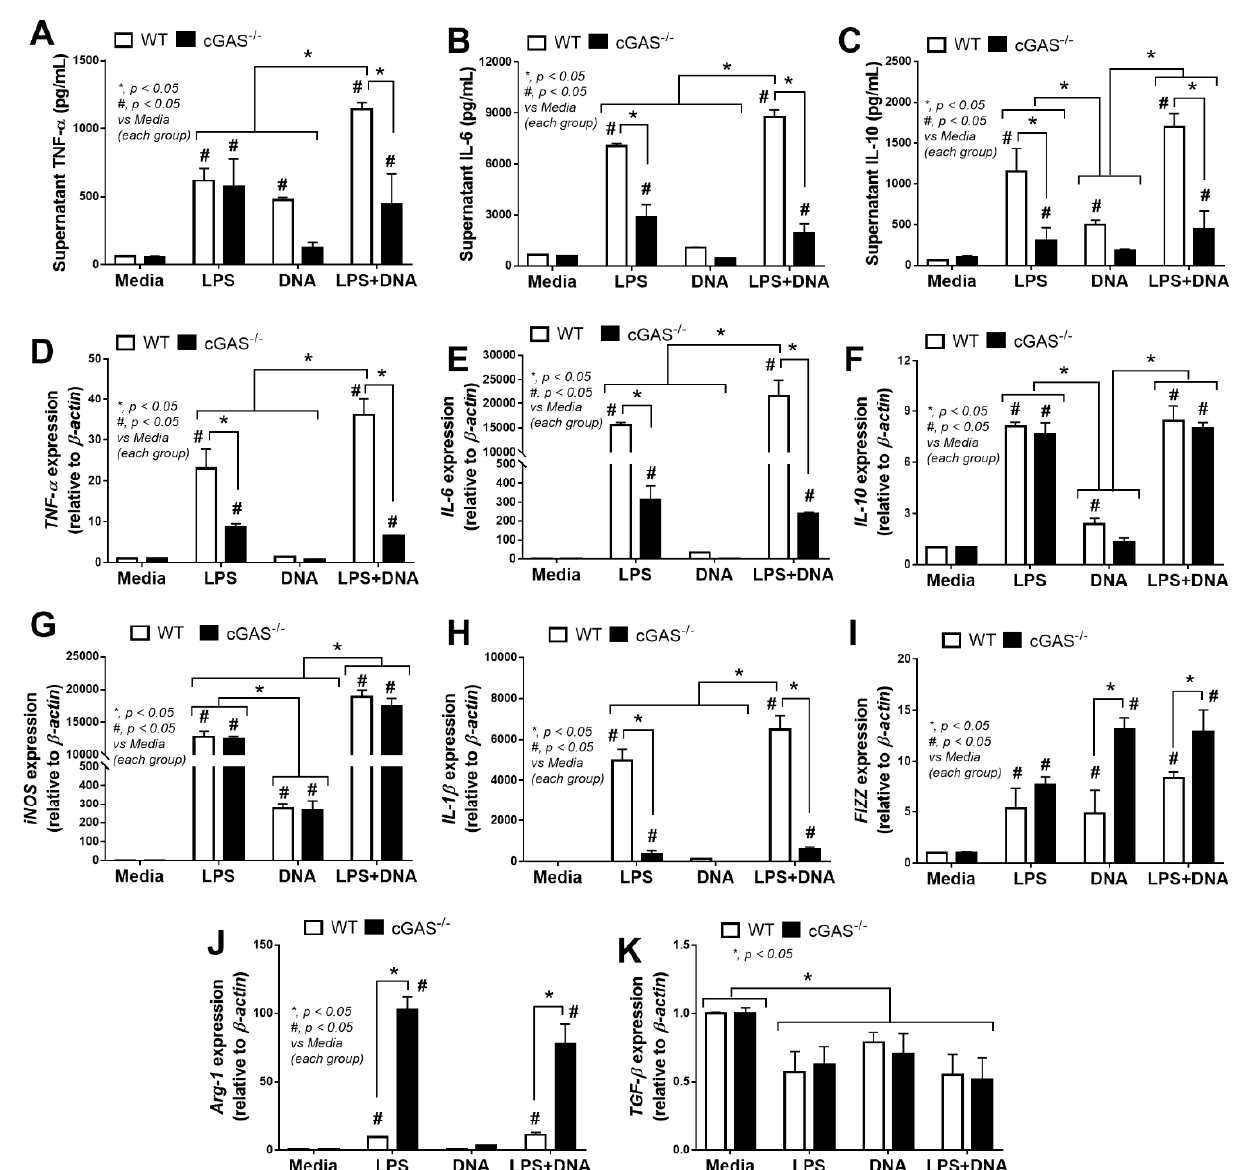
Figure 4. Characteristics of macrophages from wildtype (WT) and cyclic GMP–AMP synthase deficient (cGAS -/- ) mice after an activation by media control, lipopolysaccharide (LPS), bacterial DNA (DNA) and LPS with DNA (LPS + DNA), as indicated by supernatant cytokines (TNF- α , IL-6 and IL-10) ( A – C ) and the expression of genes for cytokines ( TNF- α , IL-6 and IL-10 ) ( D – F ), M1 macrophage polarization ( iNOS and IL-1 β ) ( G , H ) and M2 macrophage polarization ( FIZZ-1, Arg-1 and TGF- β ) ( I – K ). Independent triplicated experiments were performed.